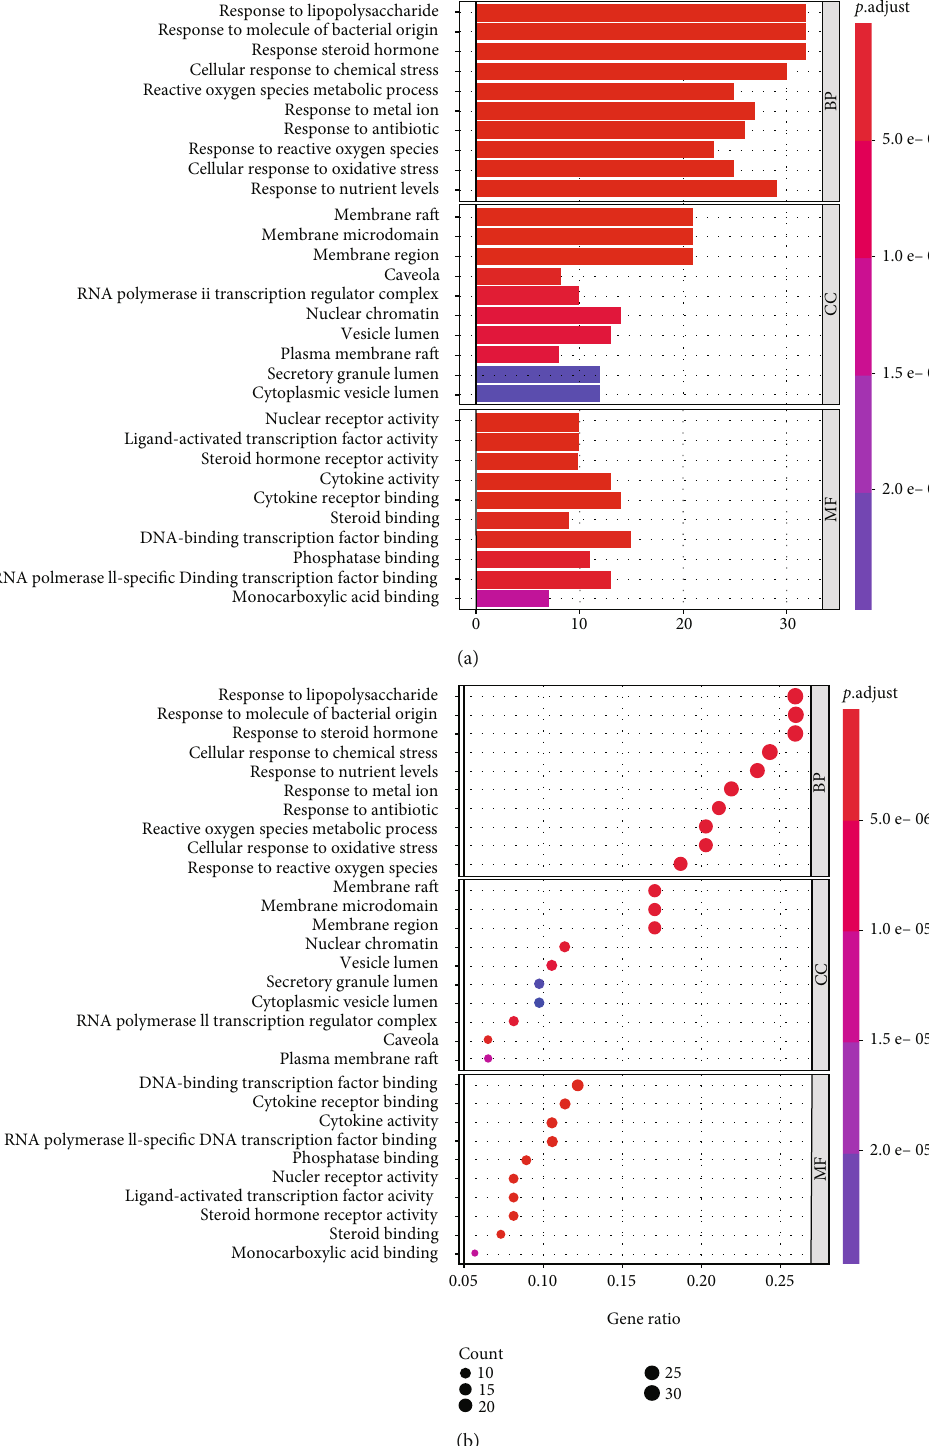
Figure 5: GO enrichment analysis of WHQD targets in treating PCOS. (a) The horizontal axis of BP, CC, and MF bar represents the number of genes enriched in each, while the color visualizes the signi fi cance based on the corrected P value. (b) The bubble diagram demonstrates the gene proportion enriched in each